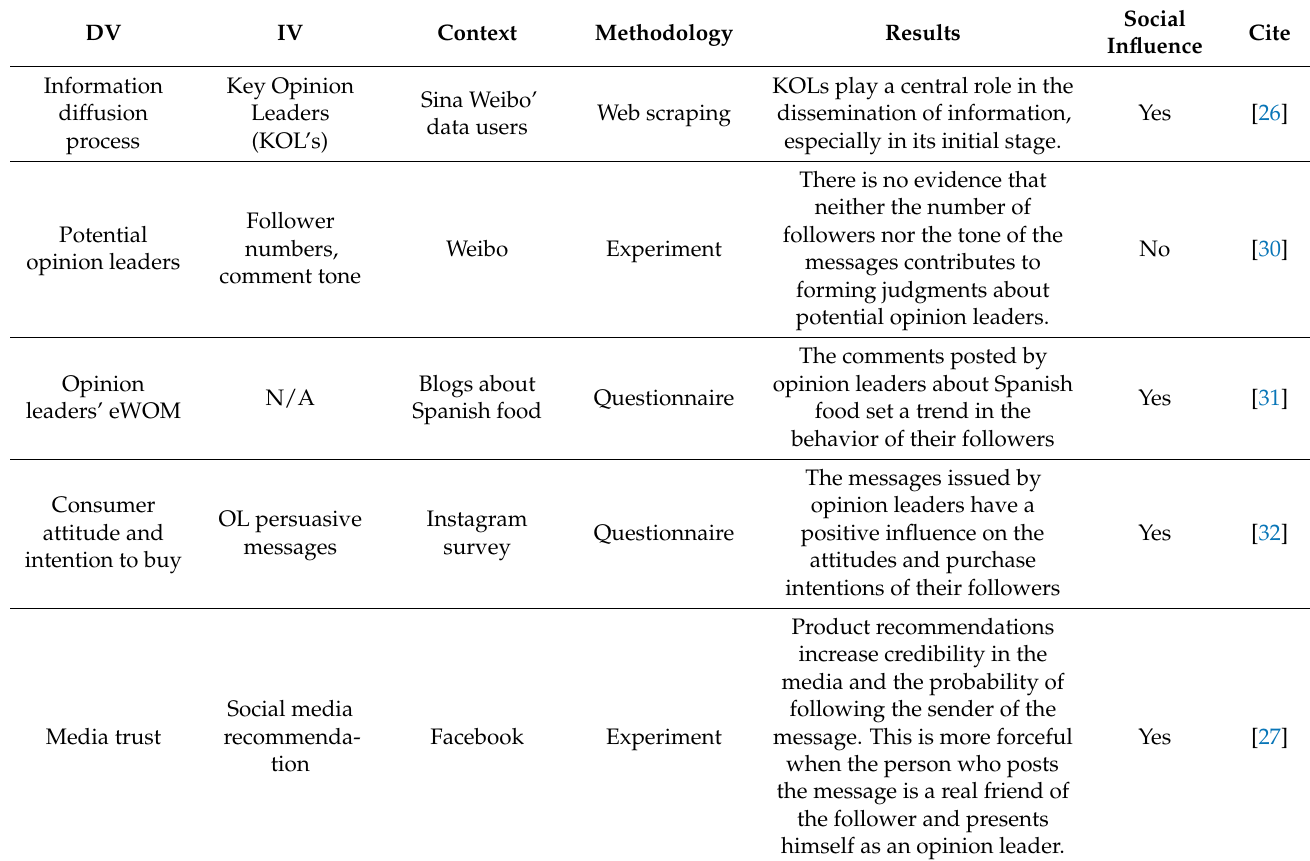
Table 1. Recent empirical evidence on Opinion